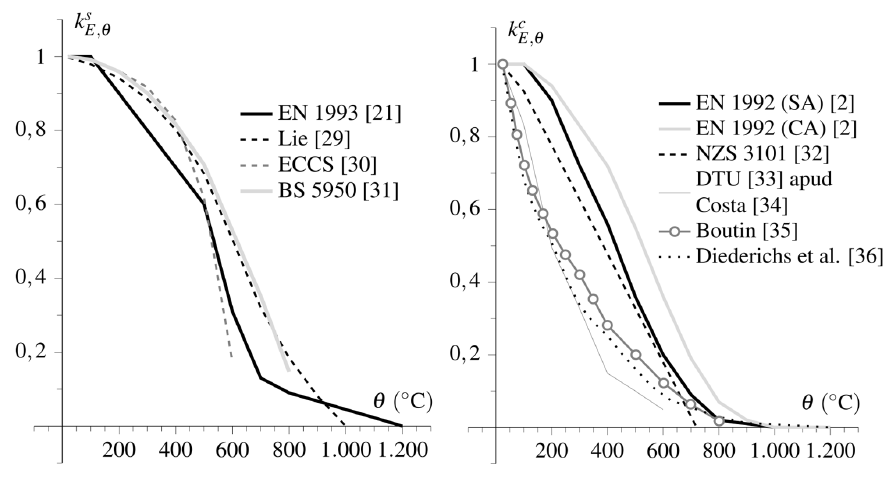
( ) s k θ and concrete E,